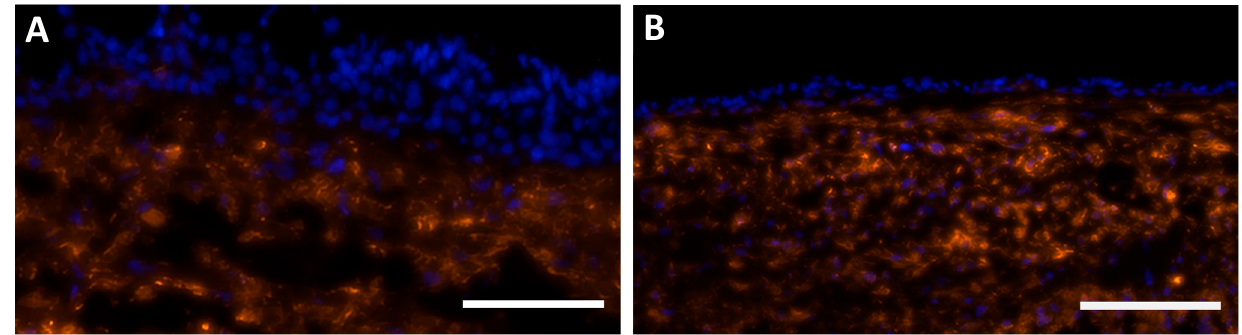
Figure 3. Characterization of the stromal compartment. Immunofluorescence staining against vimentin (orange) on cross sections of 3D models after 21 days of cultivation with ( A ) AECG (n = 9 from four donors) and ( B ) PC ALI medium (n = 7 from four donors). Nuclei were stained with DAPI (blue). Scale bar: 200 µm.